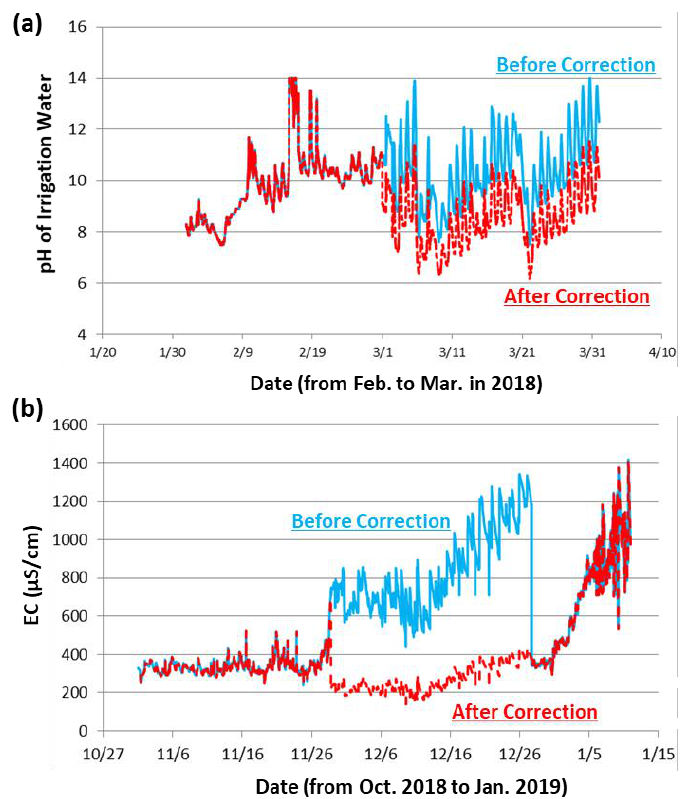
Figure 4. ( a ) Trend of pH value before (solid, light blue color) and after (dash, light red color) correction: in the case of the drainage station of Sanjia Village, Changhua; ( b ) trend of electrical conductivity (EC) value before (solid, light blue color) and after (dash, light red color) correction: in the case of Taichung Babao Irrigation Ditch.